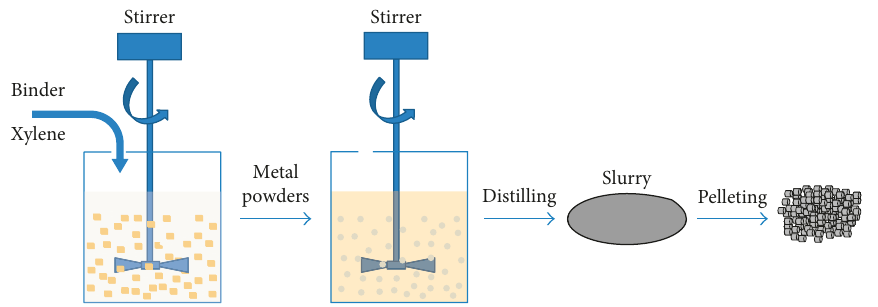
Figure 2: The flowchart of the feedstocks preparation process.